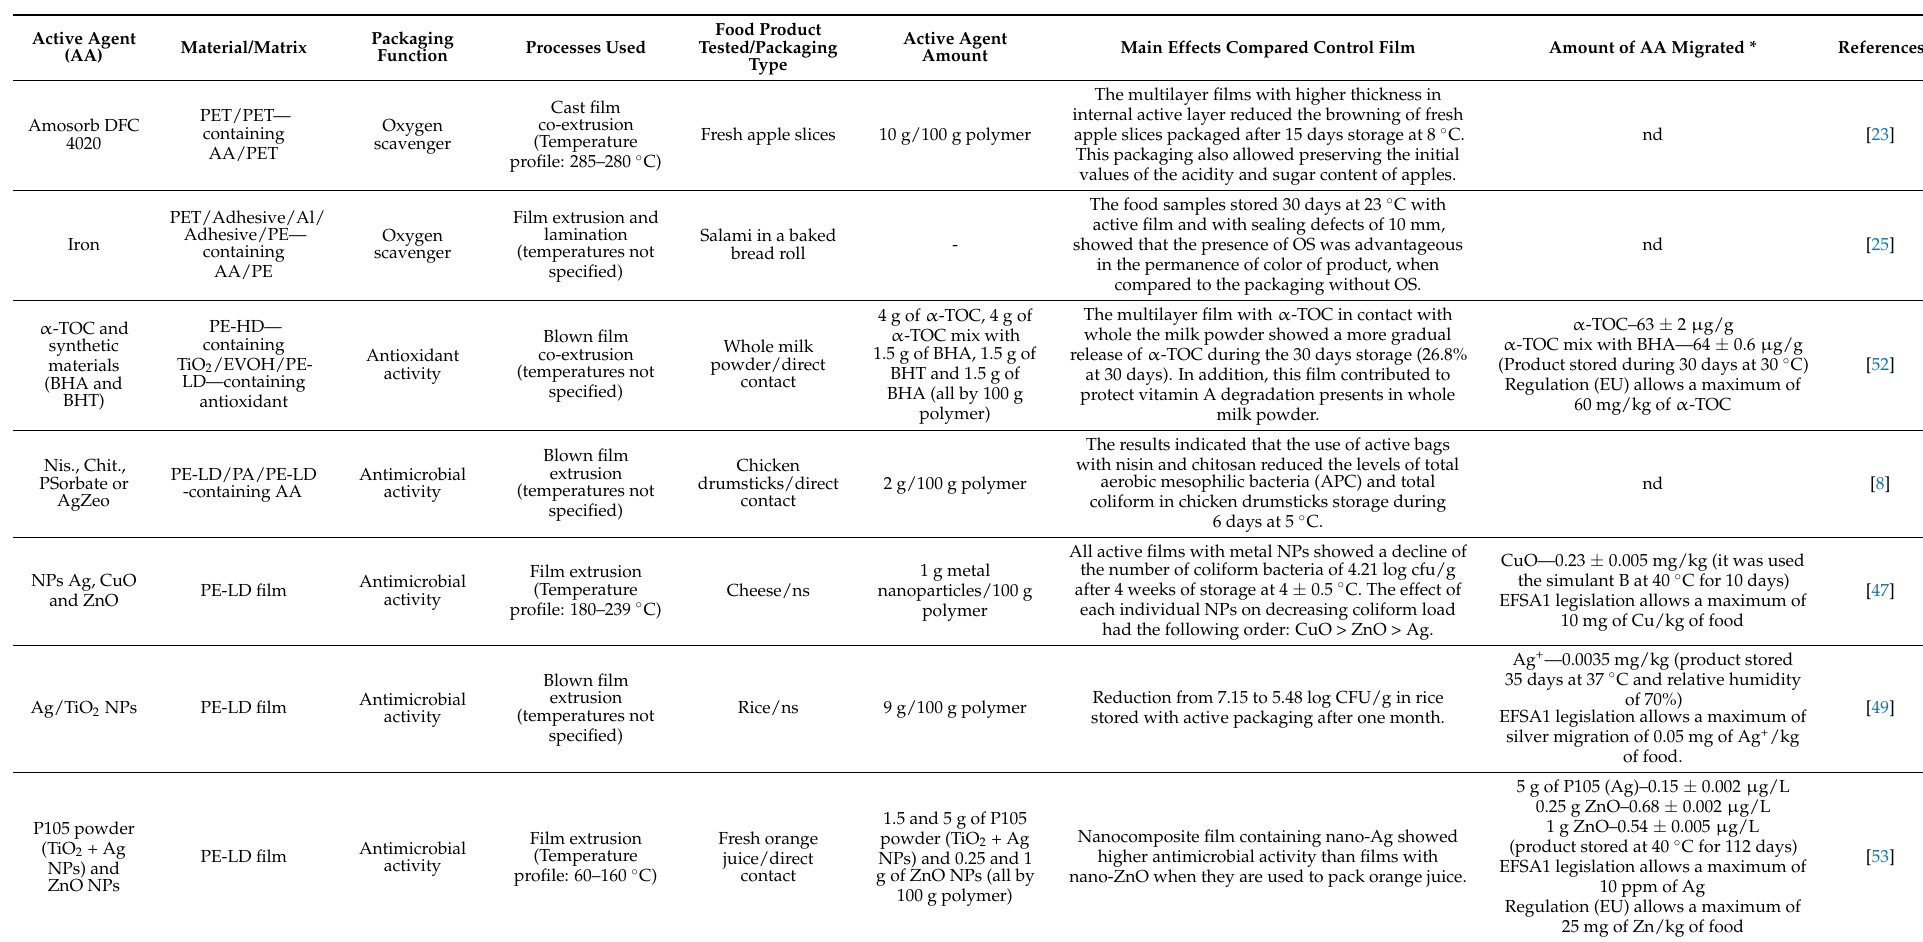
Table 2. Active agent incorporated directly in the polymer